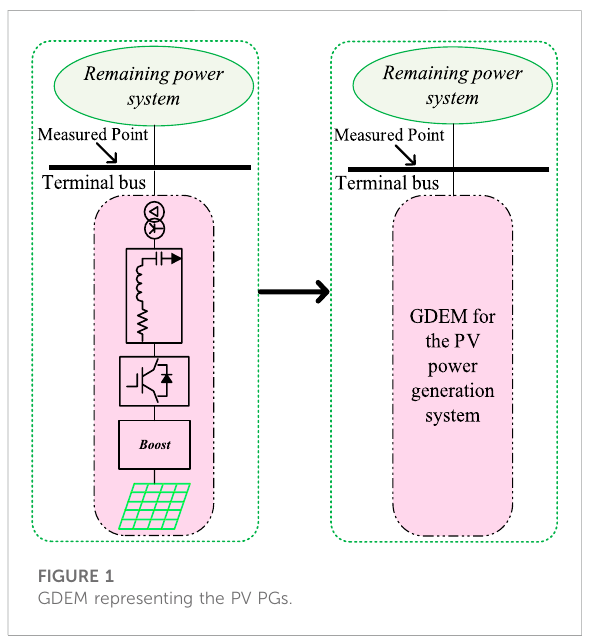
FIGURE 1 GDEM representing the PV